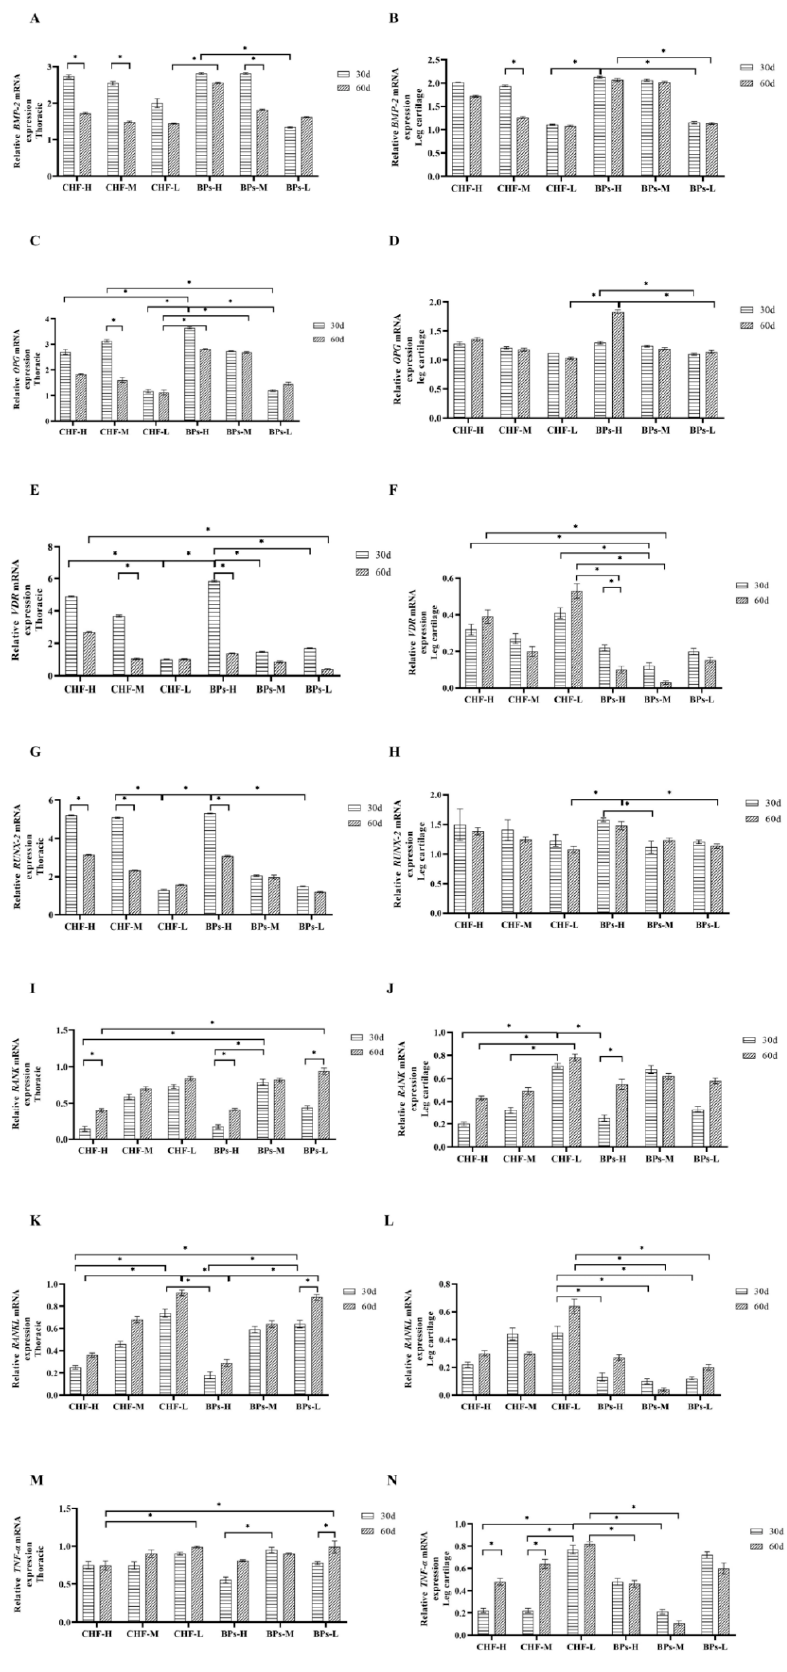
Figure 5. Comparison of relative mRNA expression levels of bone metabolism-related genes